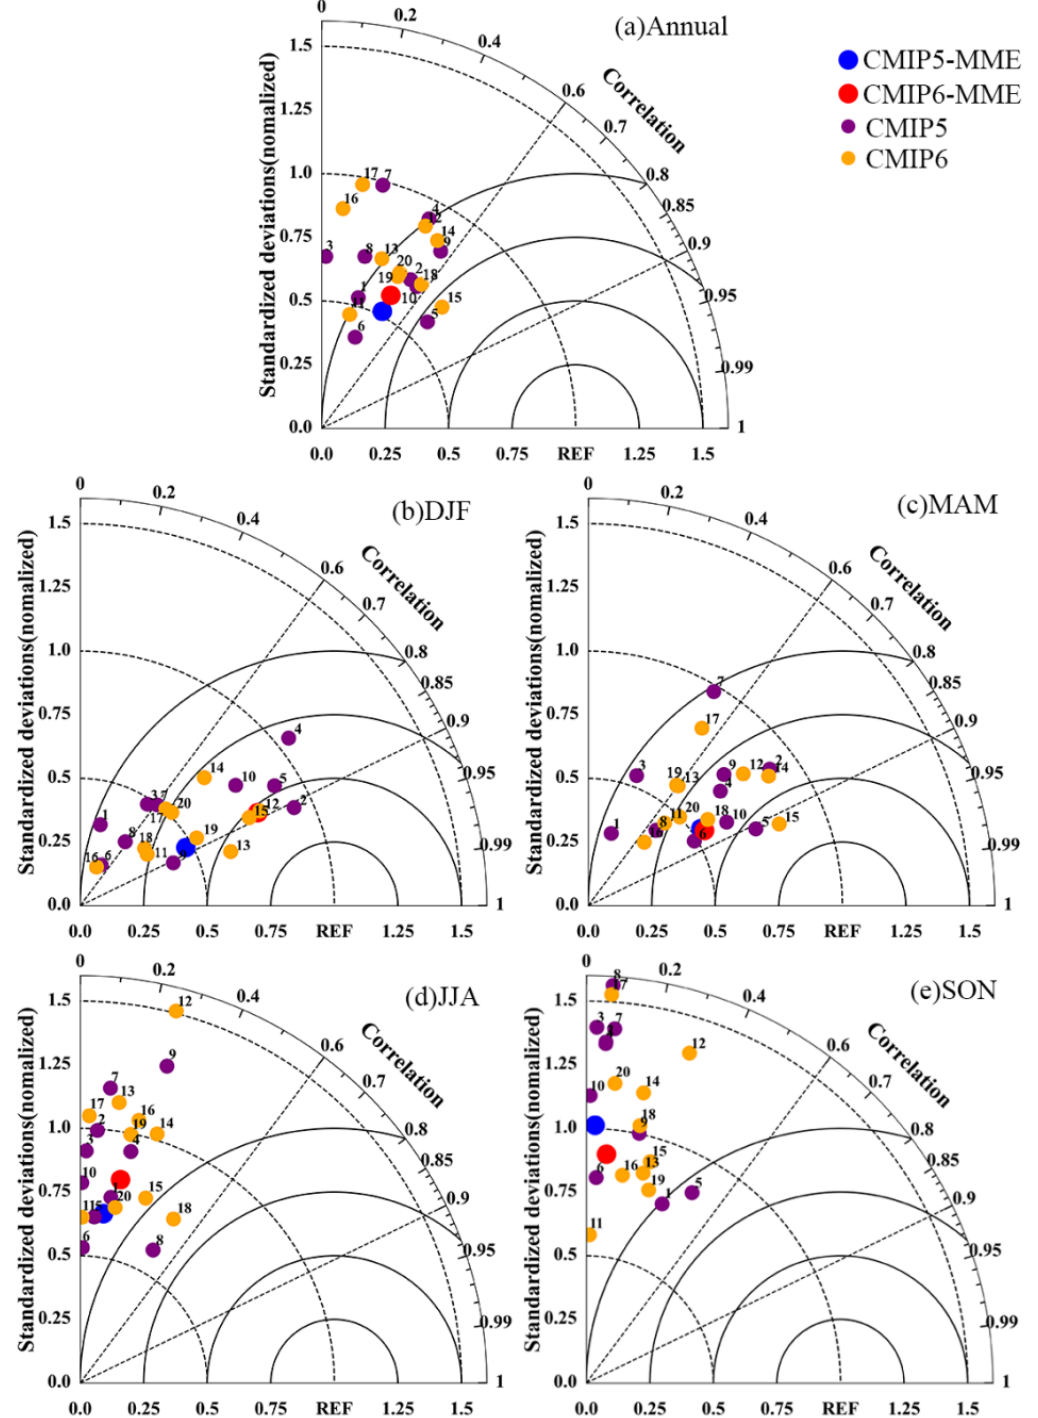
Figure 6. Taylor diagrams displaying normalized pattern statistics of multi-year average ( a ) annual; ( b ) DJF; ( c ) MAM; ( d ) JJA; ( e ) SON precipitation over YRB between 20 GCMs and observations for the period 2015–2020. The normalized CRMSE between a GCM and observation (marked as REF) is their distance apart. The numbers indicate CMIP5 and CMIP6 GCMs listed in Table 1, respectively. Blue and red asterisks represent the median of the 10 CMIP5 and 10 CMIP6 GCMs,